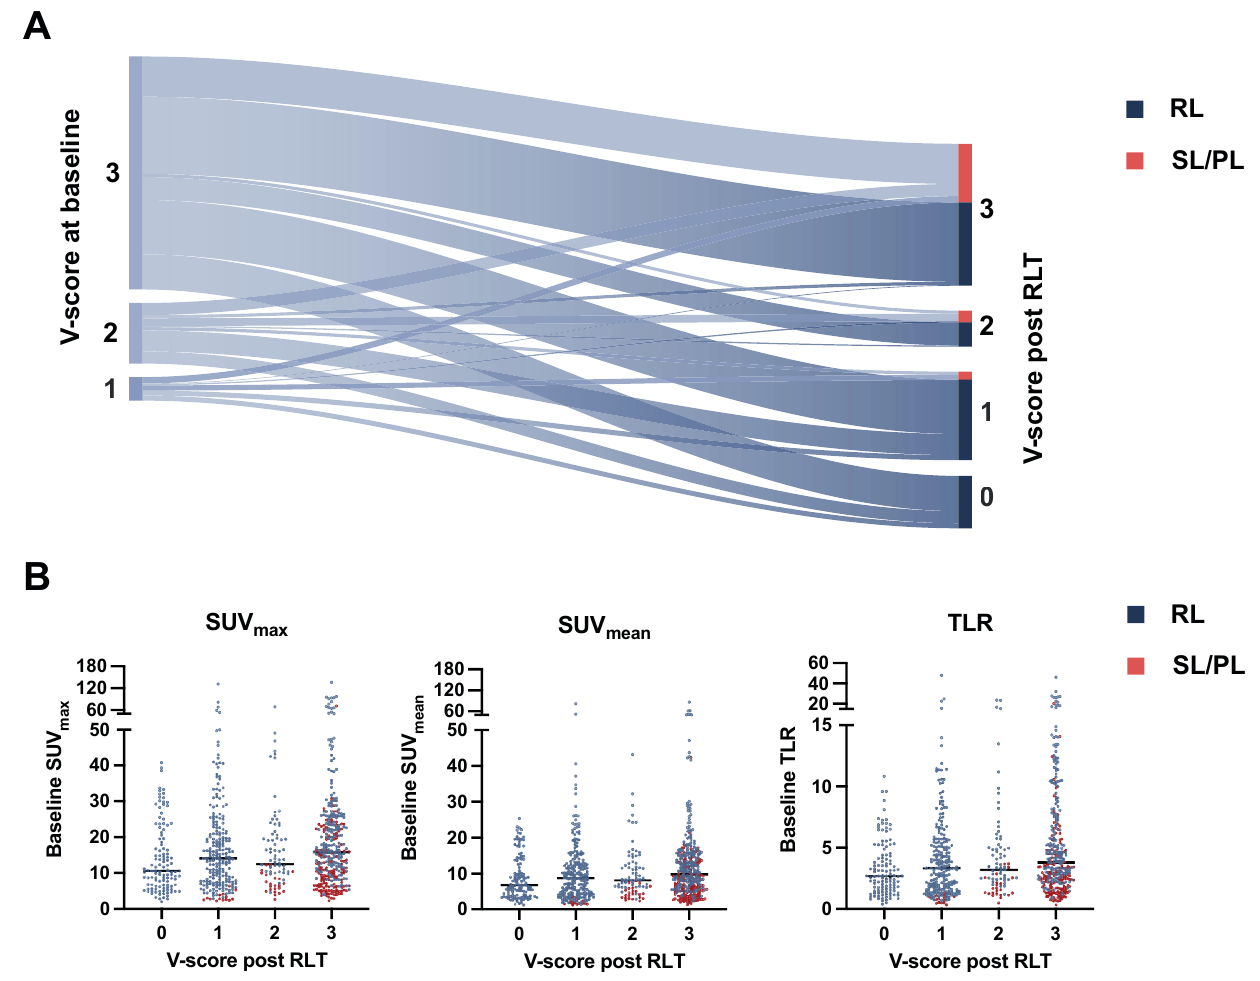
Figure 6. Sankey diagram with change in V-score from baseline to posttherapeutic imaging ( A ). Beeswarm plot stratifying baseline PET metrics (SUV max , SUV mean , TLR) with median values (line) by posttherapeutic V-score and lesion response ( B ). RL: responding lesions, SL: stable lesions, PL progressive lesions, SUV: standardized uptake value, TLR: tumor-to-liver ratio.